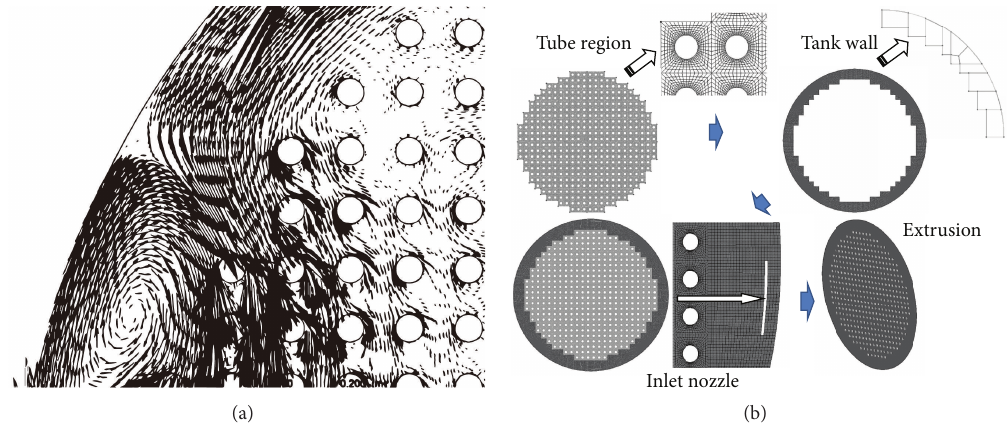
Figure 4: An example of numerical result for the computation of a 2D moderator model of CANDU-6 reactor with ANSYS-CFX: a cross- sectional view, (a) velocity vectors (partial), and (b) process for grid construction [13].